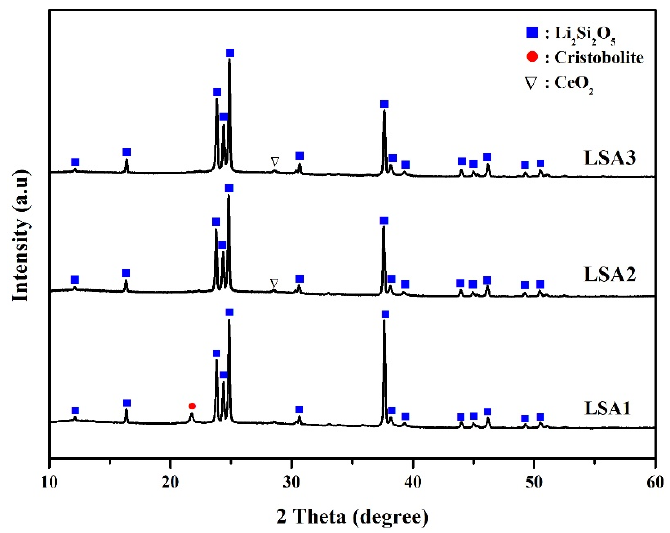
Figure 2. XRD analysis of glass-ceramic samples with various Al 2 O 3 contents after heat treatment.